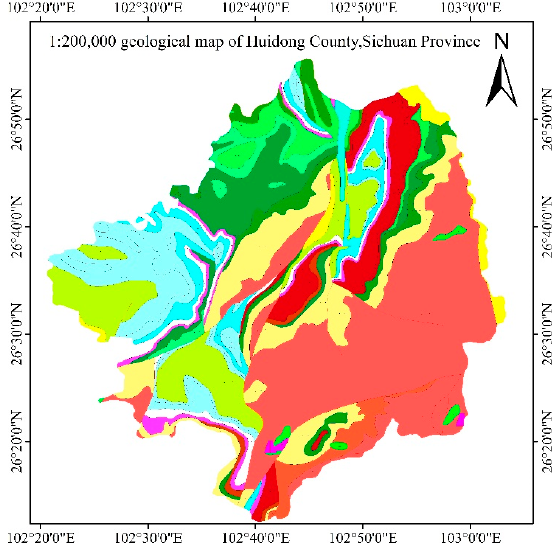
Figure 2. 1:200,000 Geological Map of Huidong County, Sichuan Province.